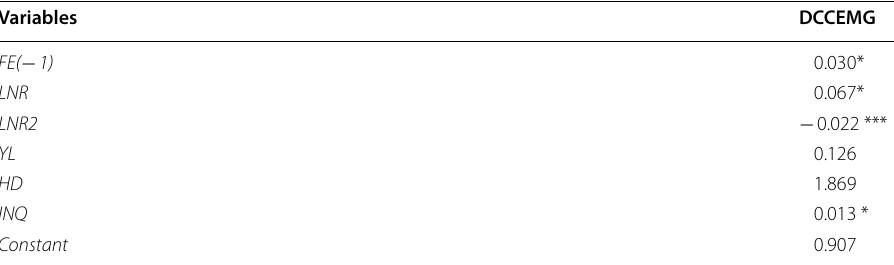
Table 10 DCCEMG outcomes